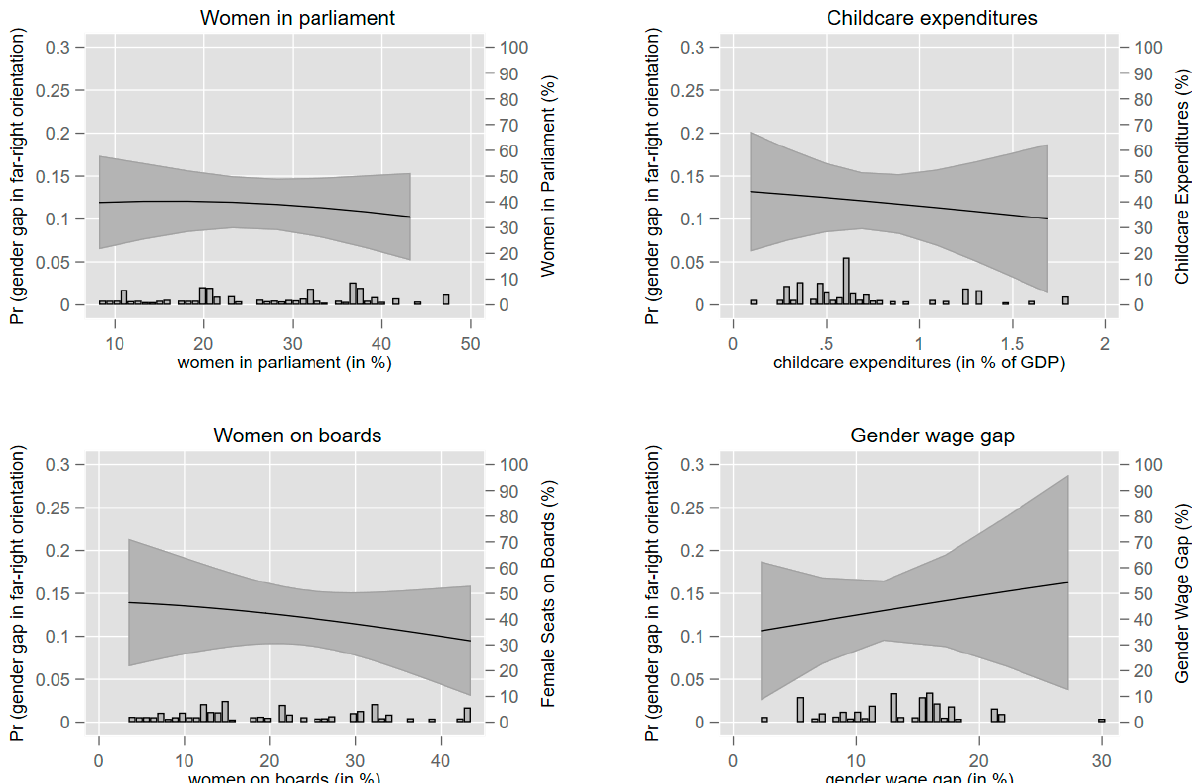
Figure 2. Average marginal effects of the gendered division of work on the gender gap in far-right orientation. Own illustration based on the European Values Study 2008 and 2017, the OECD Social Expenditure Aggregated Dataset, the Comparative Welfare States Data Set, and World Bank Gender Statistics. 95% confidence intervals, fixed portion only.